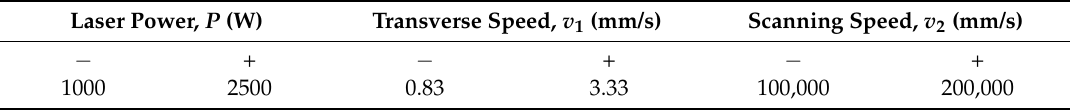
Table 1. Factors and levels for the 2 3 full factorial design.